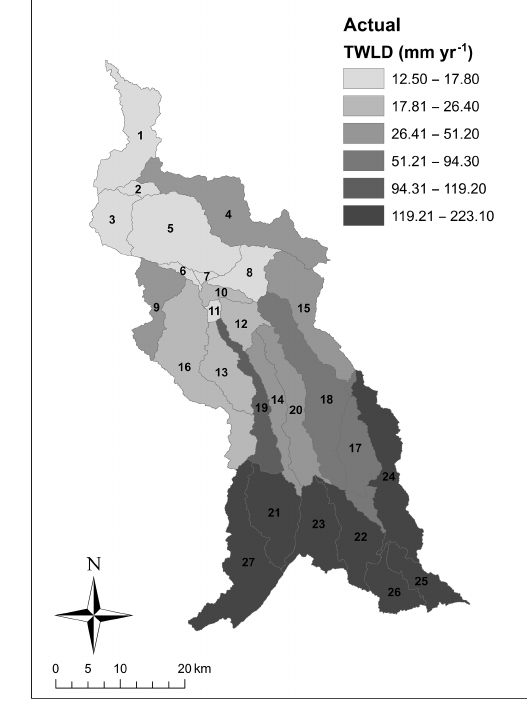
Figure 4. Average of simulated total water yield by sub-basins un- der for the period 2004 to